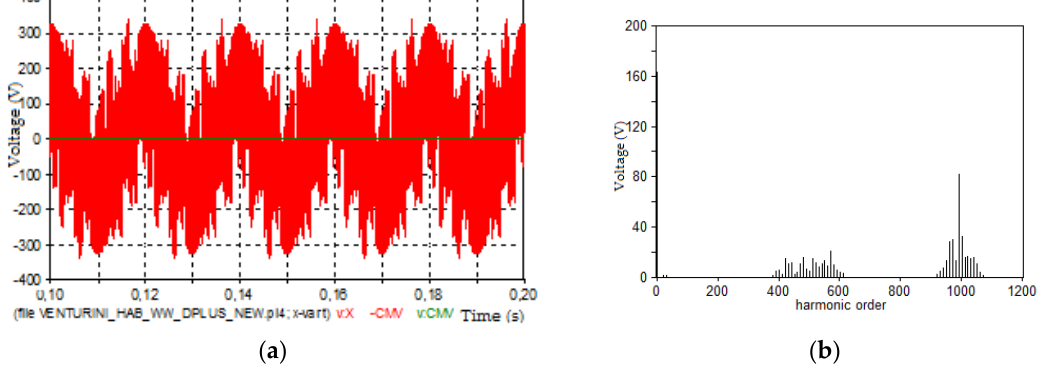
Figure 6. Waveforms of the output voltages (red lines) and CMV (green line) ( a ) and Fourier analysis of the output voltage ( b ), synthesized in MMC and controlled by the use of CW rotating space vectors, for the angle ψ = 0 ◦ and output frequency of 50